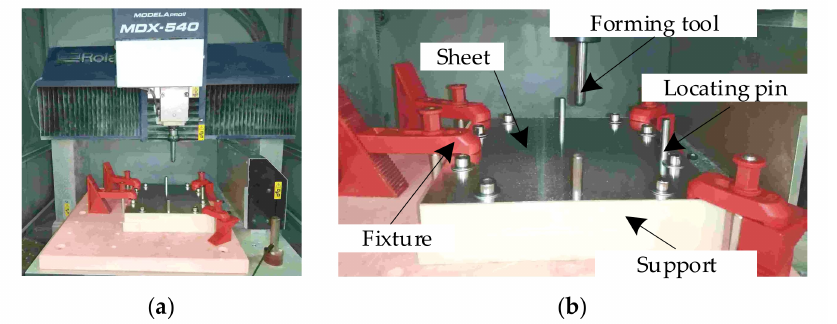
Figure 26. Forming equipment: ( a ) Roland 3D mold-engraving machine MDX-540; ( b ) the form- ing process.